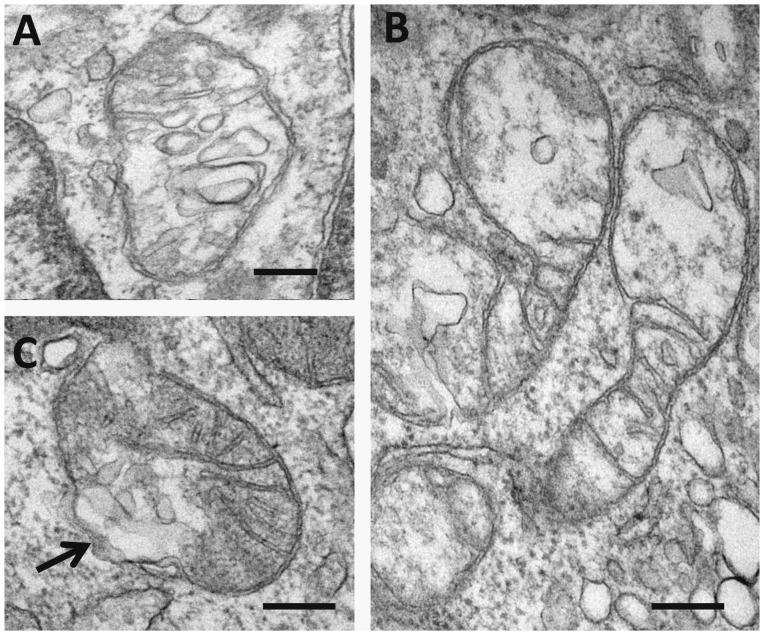
Ultrastructural appearances of mitochondria in leukocytes obtained from patients with carotid atherosclerosis (A–C).In (A, B), note a profound focal oedema of the mitochondrial matrix and destructive alterations of cristae. In (C), a zone of destruction of the outer mitochondrial membrane in shown by arrow (A–C): Electron microscopy. Scales = 150 nm.